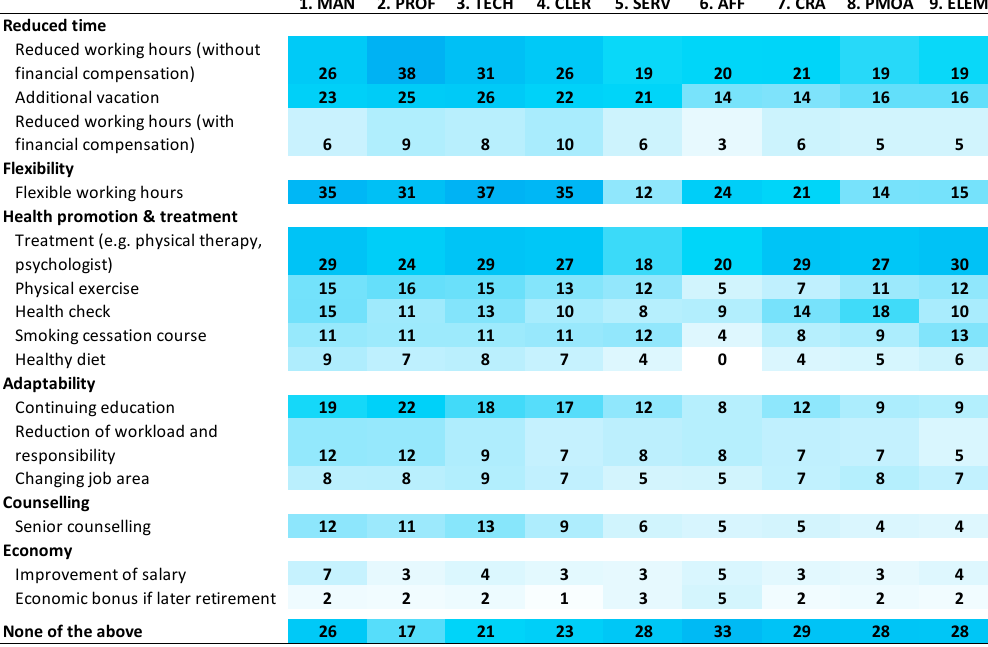
Figure 1. Colour-intensity map of available opportunities at the workplace in the 9 ISCO groups. Prevalence (percentage of respondents) is provided in each box. 1. Managers (MAN), 2. Professionals (PROF), 3. Technicians and Associate Professionals (TECH), 4. Clerical Support Workers (CLER), 5. Services and Sales Workers (SERV), 6. Skilled Agricultural, Forestry and Fishery Workers (AFF), 7. Craft and Related Trades Workers (CRA), 8. Plant and Machine Operators and Assemblers (PMOA), 9. Elementary Occupations (ELEM). Table 2. Availability of different opportunities at the workplace among men and women in ISCO groups 1–4 and 5–9, respectively, provided as prevalence (percentage of respondents) and 95% confidence intervals. ORs for ISCO group 5–9 (ref: ISCO groups 1–4) and women (ref: men) are provided in the last two columns.